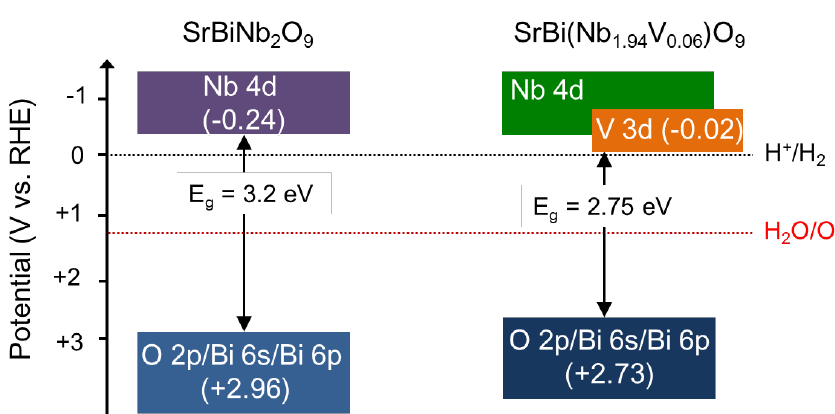
Figure 5. Schematic band structure and positions (on the electrochemical scale) of SrBi 2 Nb 2 O 9 and SrBi 2 Nb 2 – x V x O 9 (x = 0.06).